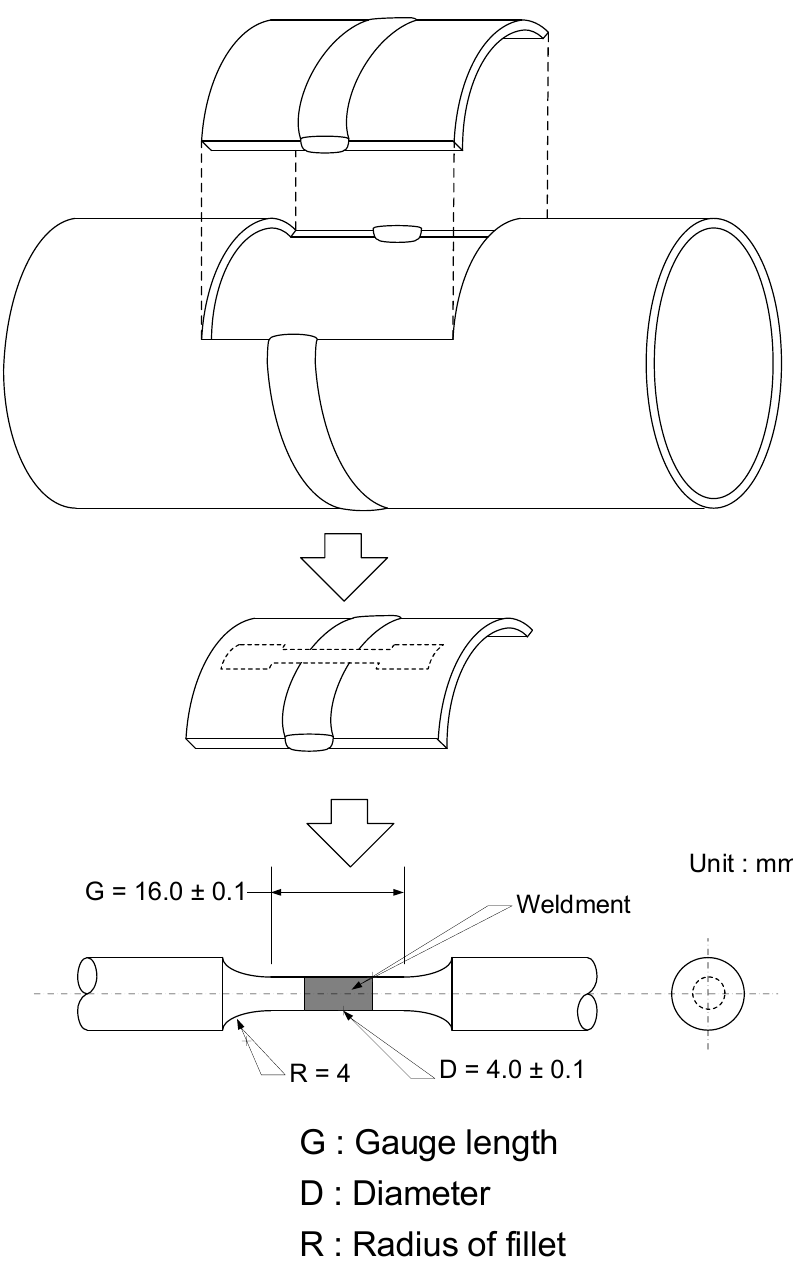
Figure 1. Schematic illustration of sectioning procedures to prepare tensile test specimen from welded pipes. Table 3. Chemical composition of the synthetic district heating water (mg/L).